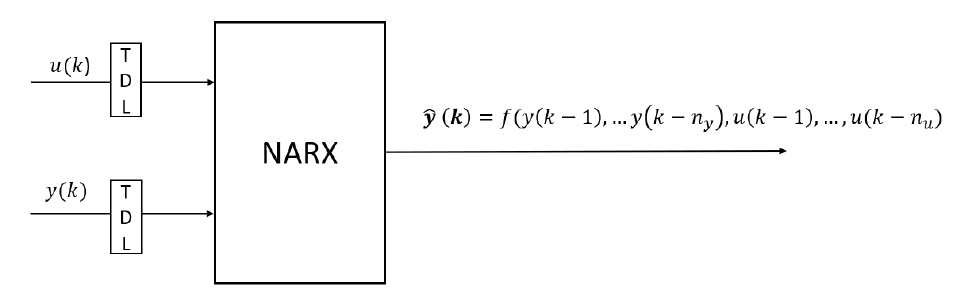
Figure 3. NARX series parallel type-model